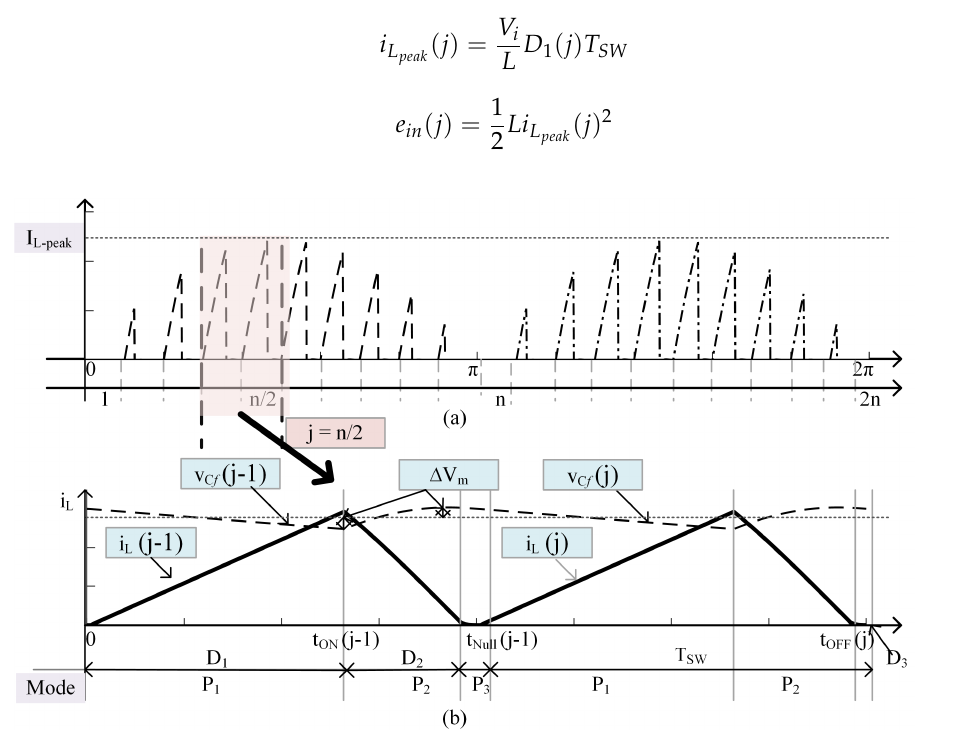
Figure 4. ( a ) Inductor current ( I L ), ( b ) Inductor current and capacitor voltage during the peak switching